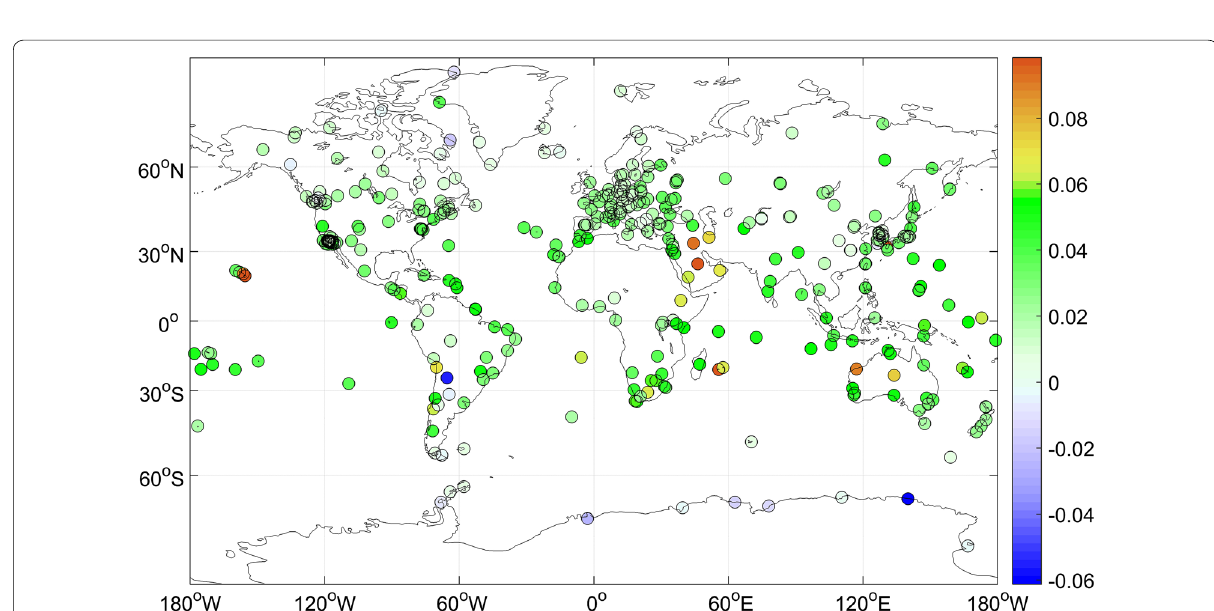
Fig. 7 Wet mapping factor (unitless) bias at 3° elevation angle for the GPS DDA